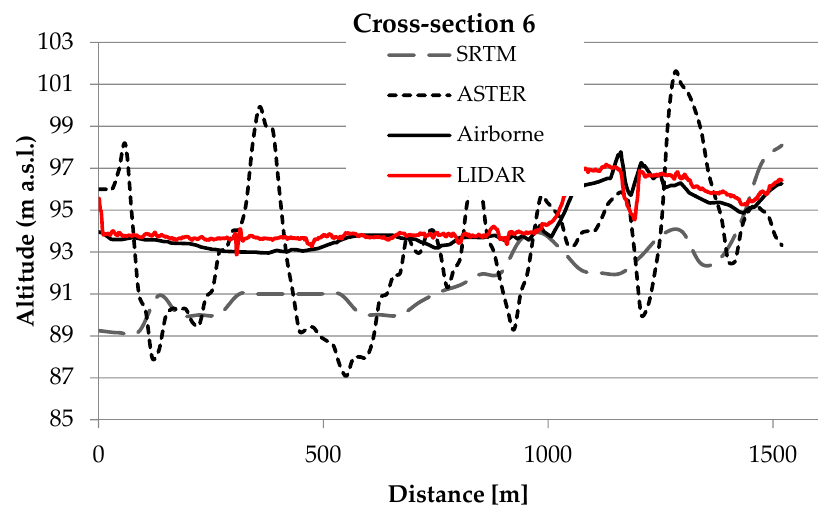
Figure 11. Comparison of cross-sections through the polder for different models of DEM.